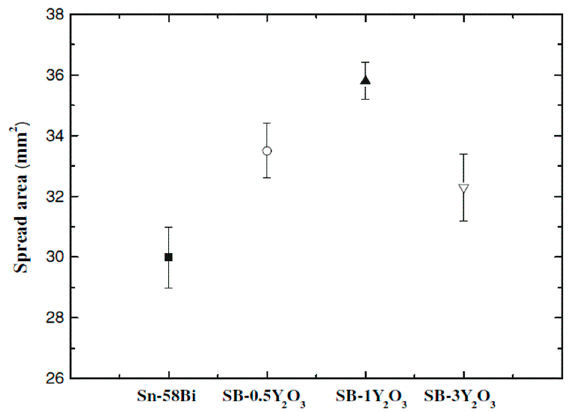
Figure 10. The effect of Y 2 O 3 content on the spread area of SnBi–nano Y 2 O 3 composite solder on the Cu substrate [66].